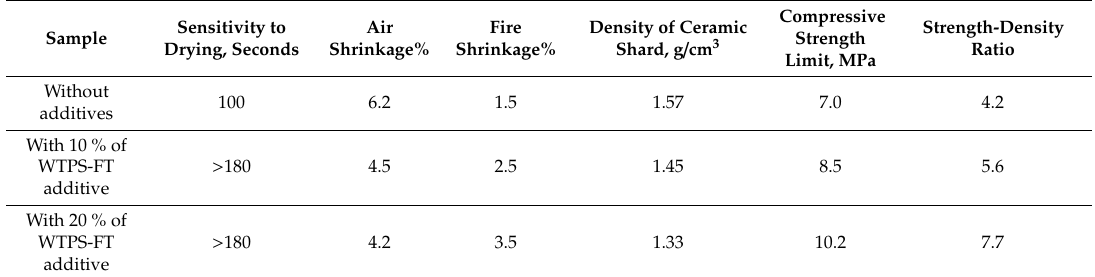
Table 5. Strength of ceramic